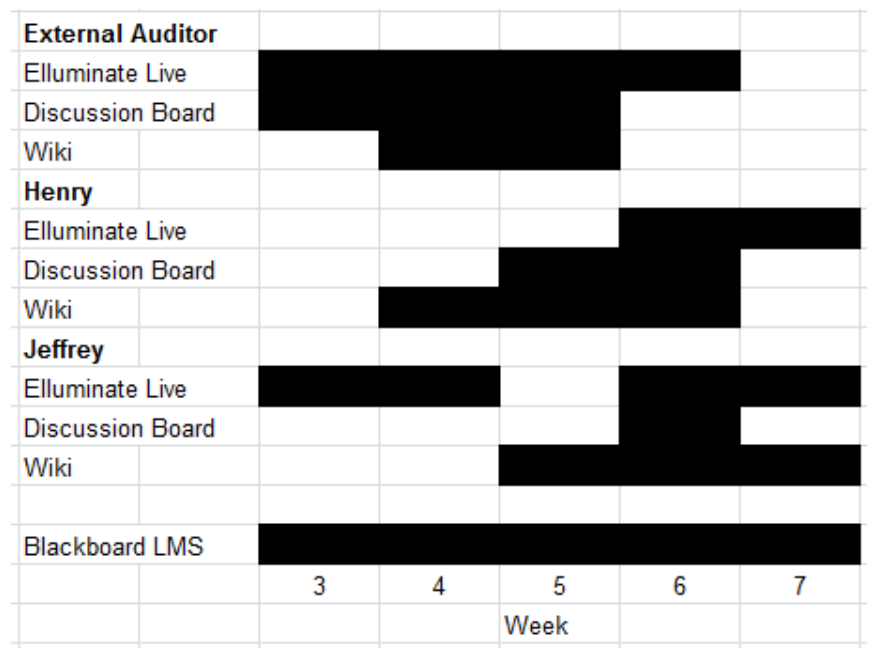
Figure 2. Timeline for Case 1 (AFA), showing the use of Web 2.0 tools over the teaching session. External Auditor, Henry and Jeffrey are names for the three student groups engaged in this learning